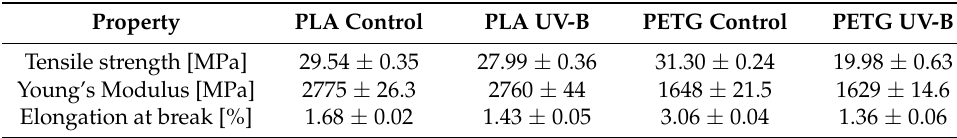
Figure 5. Tensile strength testing results, with Young’s Modulus and tensile stress at tensile strength: ( a ) PLA control group; ( b ) PLA with UV-B exposure; ( c ) PETG control group; ( d ) PETG with UV-B exposure. Table 2. Tensile strength and